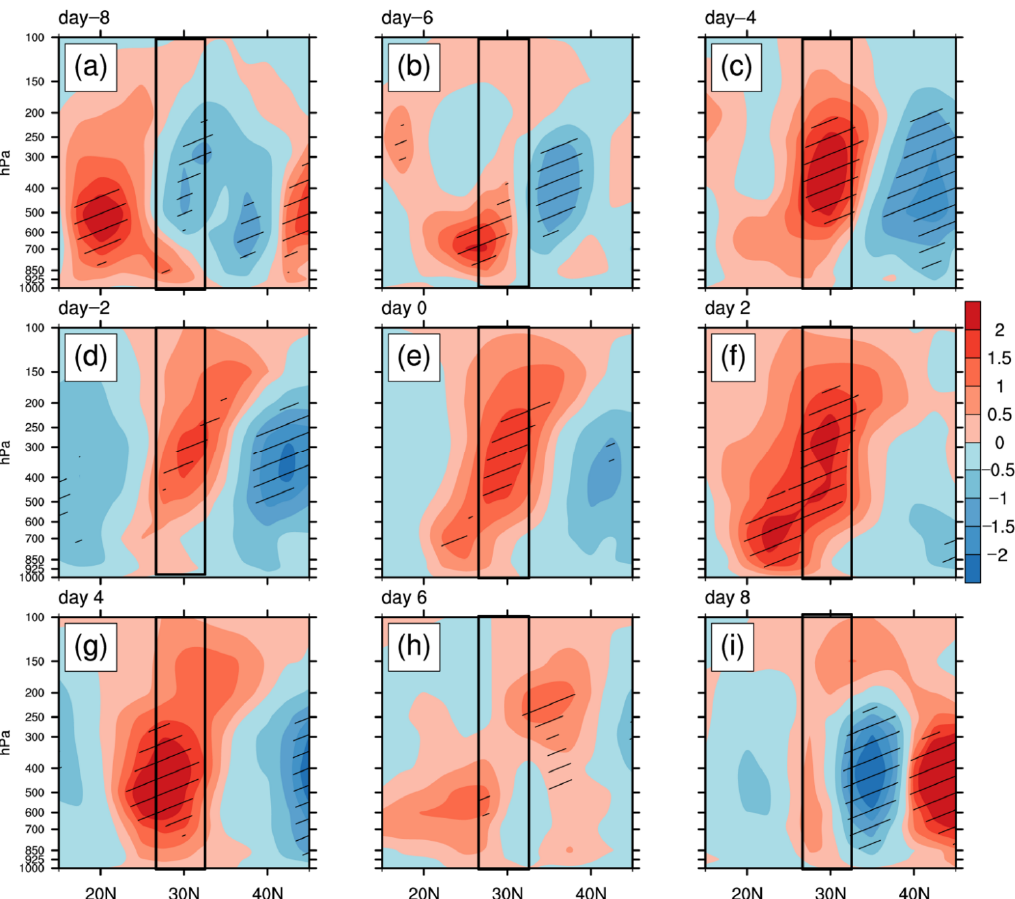
Figure 11. Latitude-pressure cross-section (114–122° E) of vertical p -velocity (shading; units: hPa s −1 ) during the SR+ events from day −8 to day 8 ( a – i ). The slash shadings indicate that the anomalies are statistically significant at the 0.05 confidence level. Black rectangles denotes the YRV regions (114–122° E, 27–32° N).